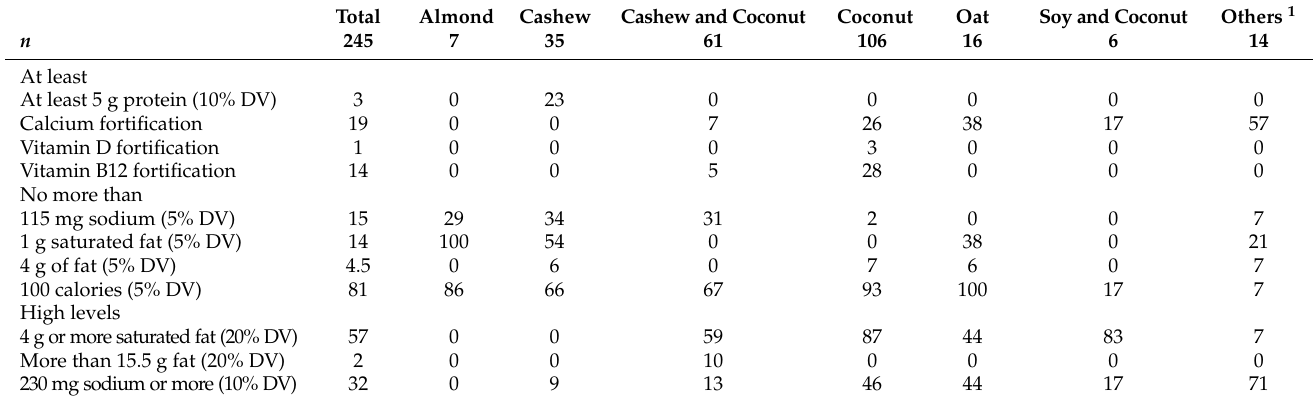
Table 2. Percentage of non-dairy cheese alternatives meeting or exceeding the suggested guidelines per serving, listed according to the base type and for the total number of cheese